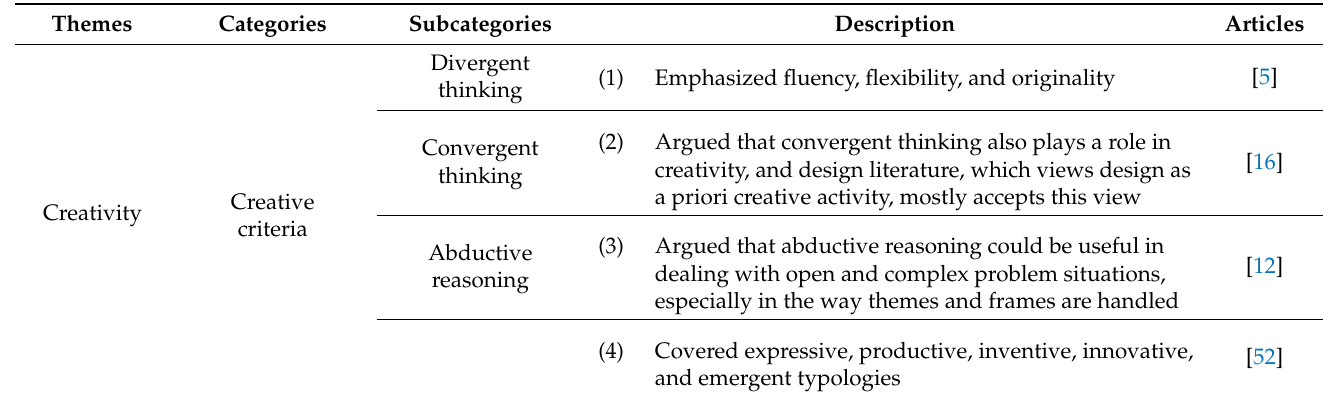
Table 5. Overall review of the 36 selected